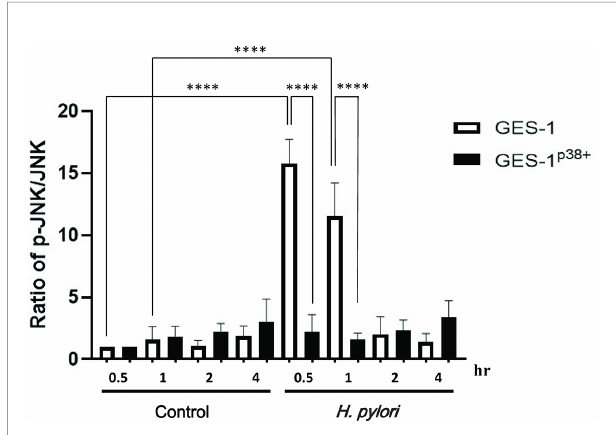
FIGURE 8 | The translation levels of p-JNK, p-p38, and p-ERK in GES-1 and GES-1 p38+ (GES-1 overexpression of p38) after H. pylori infection. p38 Human Tagged ORF Clone was transfected using TransIT-X2 into GES-1 cells. The TransIT-X2/DNA complex was then added to each area of the dish. The ratios of p-JNK/JNK in GES-1 and GES-1 p38+ cells after H. pylori infection over time are shown. Each ratio was compared to the results at 0.5 hours in the controls. Each test was performed in triplicate. (**** P <